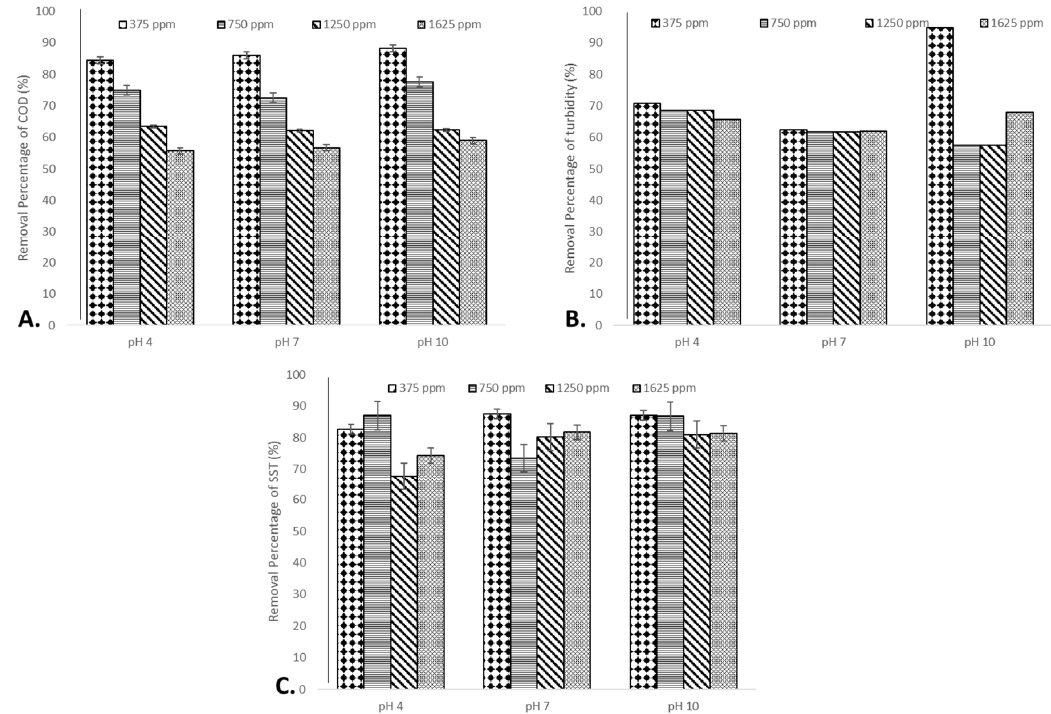
Figure 7. Removal percentages of organic material (COD), turbidity and total suspended solids (TSS) after the coagulation–flocculation process with